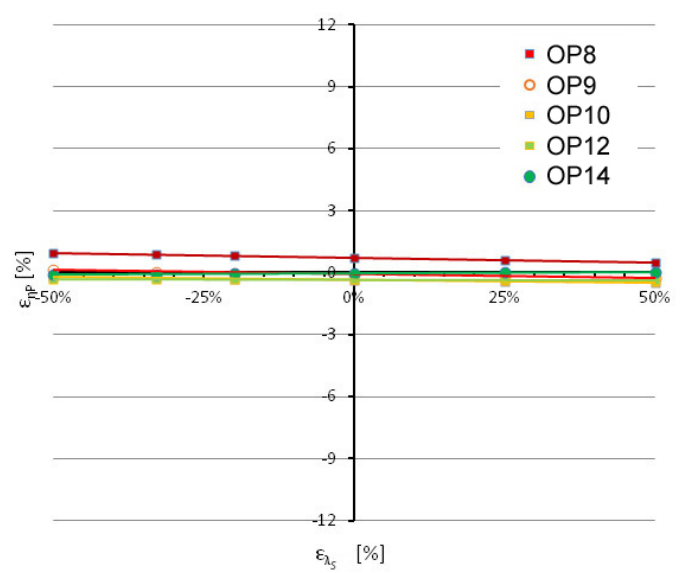
Figure 16. Algorithm sensitivity analysis regarding the determination of the pump efficiency (cid:101) η or deviations in the input of the longitudinal losses coefficient for the suction line (cid:101) λ operating points: OP8, OP9, OP10, OP12 and